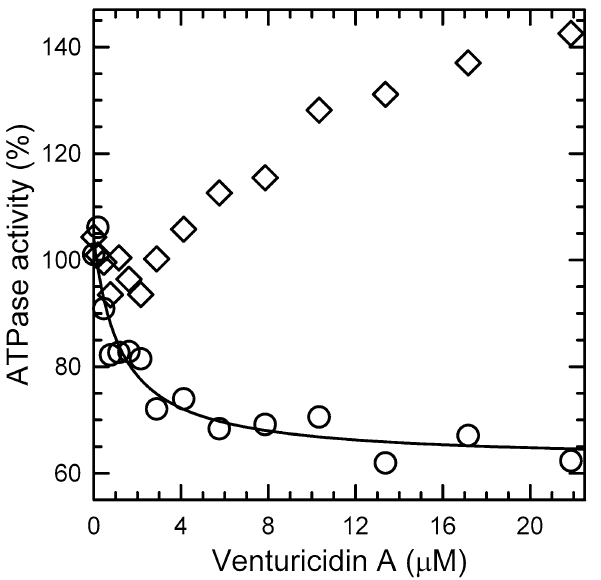
Figure 6. Complex effects of venturicidin A on ATPase rate are also observed with membranes from P. aeruginosa . PAO1 membranes (6.72 μg) were assayed in the presence of 38.5 mM selenite as for Fig. 1 and ATPase rates were measured at early ( ○ ) and late (◊) periods after adding ventA, as described for Fig. 2. The rate before ventA addition (100%) is 0.45 U/mg, and inhibition of the early rate fits a hyperbolic dependence on ventA concentration (see equation, Fig. 2 legend) with a K i = 1.2 μM (± 0.4) for 42% (± 3) ventA-sensitive ATPase and 62% (± 2) ATPase remaining at saturating